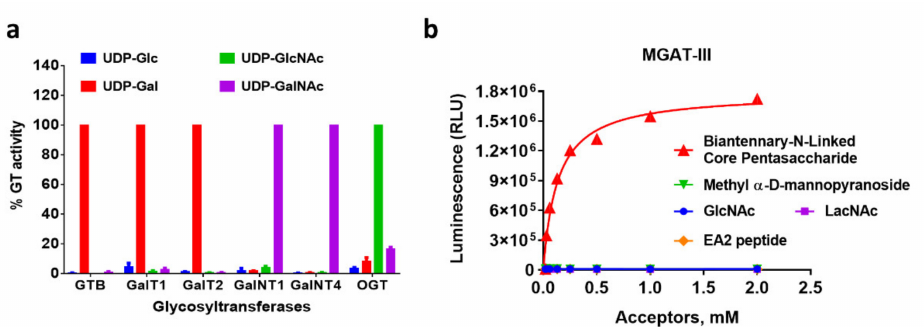
Figure 5. Determination of glycosyltransferases preference for specific nucleotide-sugar donor and acceptor substrates. ( a ) UDP-Glo detection of UDP-sugar specificity for six glycosyltransferases at one single substrate concentration. ( b ) UDP-Glo detection of acceptor substrate specificity for MGATIII using a titration of multiple substrates of different structures and the sugar donor